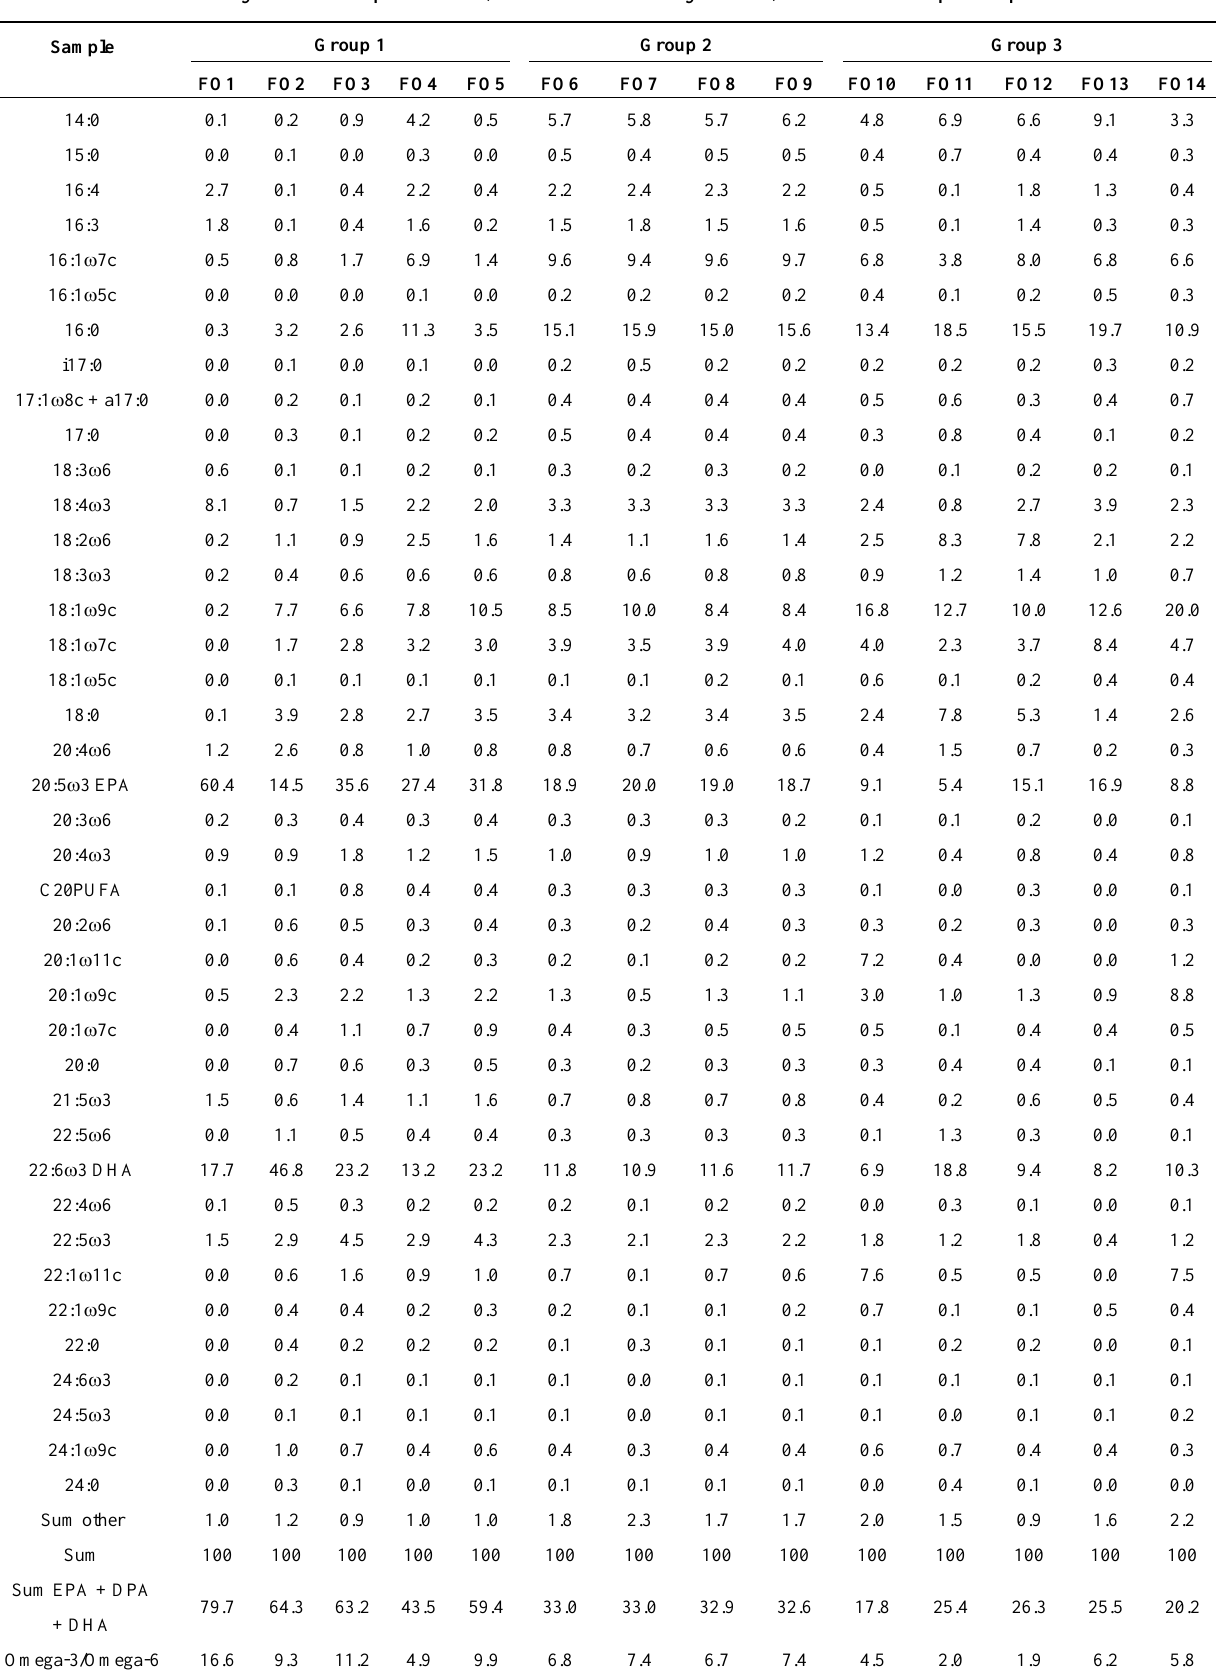
Sample codes—refer to Table 3. Abbreviations as used in Table 1. Other FA (≤0.3% of total FA): 14:1ω5c, 4,8,12TMTD, i15:0,